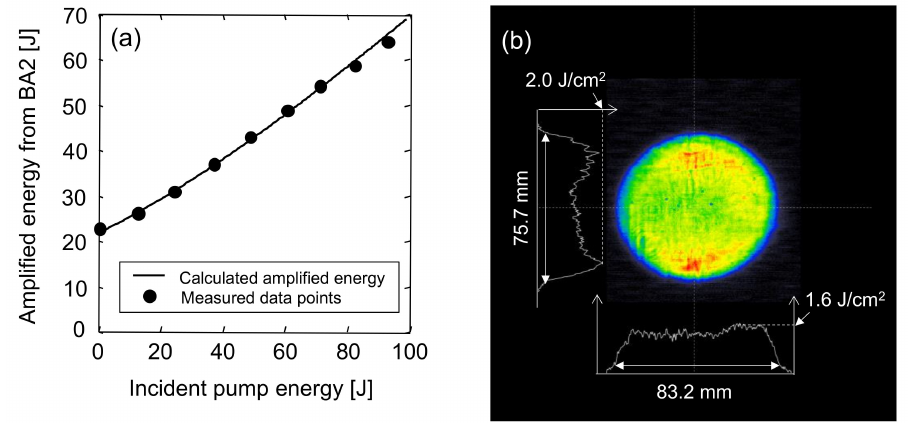
Figure 5. ( a ) Measured output energy of the final amplifier as a function of the energy of the pump laser. The theoretical curve is also shown. ( b ) Measured near-field spatial profile from the final amplifier.